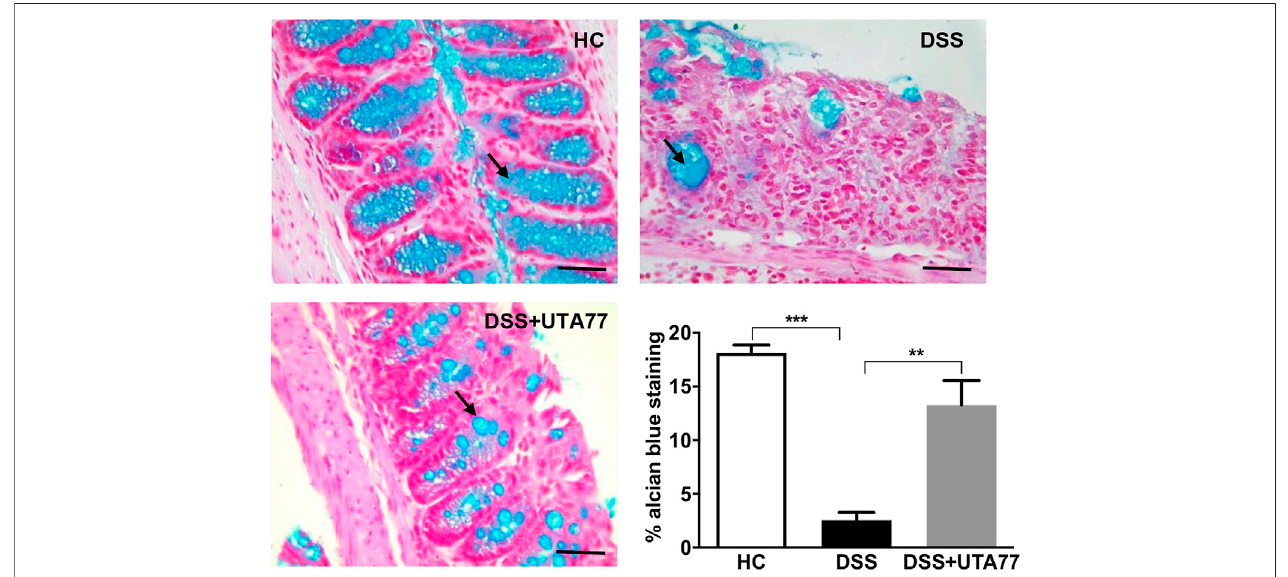
FIGURE4| EffectofUTA77ongobletcells.GobletcellsproducingmucusstainedwithAlcianBluedyeforHC,DSS,andDSS+UTA77groupsindistalcolonalong with graphical representation of staining intensity of Alcian Blue dye for each group (n (cid:1) 3/group). Statistical signi fi cance among groups evaluated by one-way ANOVA followed by Tukey ’ s posttest where **p < 0.01 and *** p < 0.001. Images at × 40 magni fi cation.